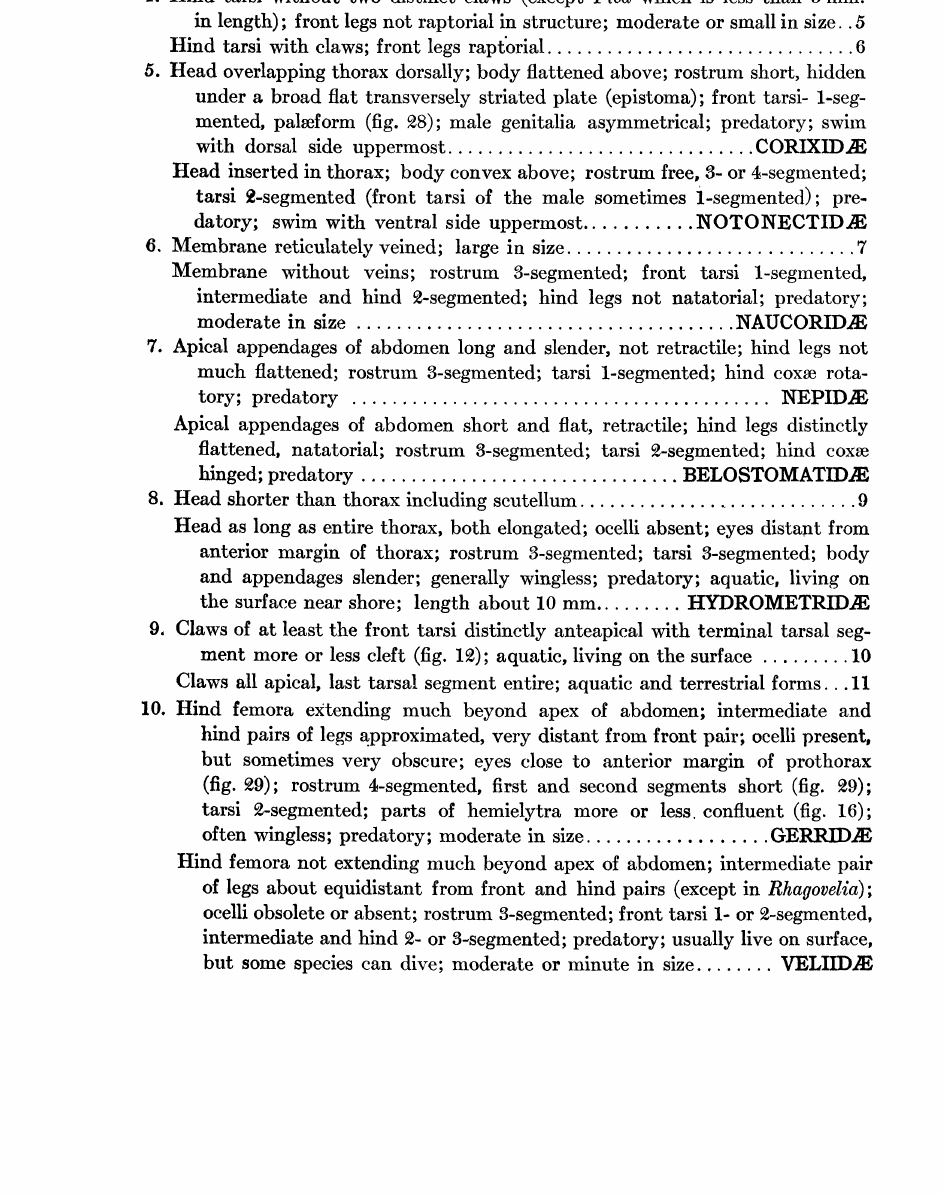
8. Anterme exposed; front legs similar to intermediate; rostrum